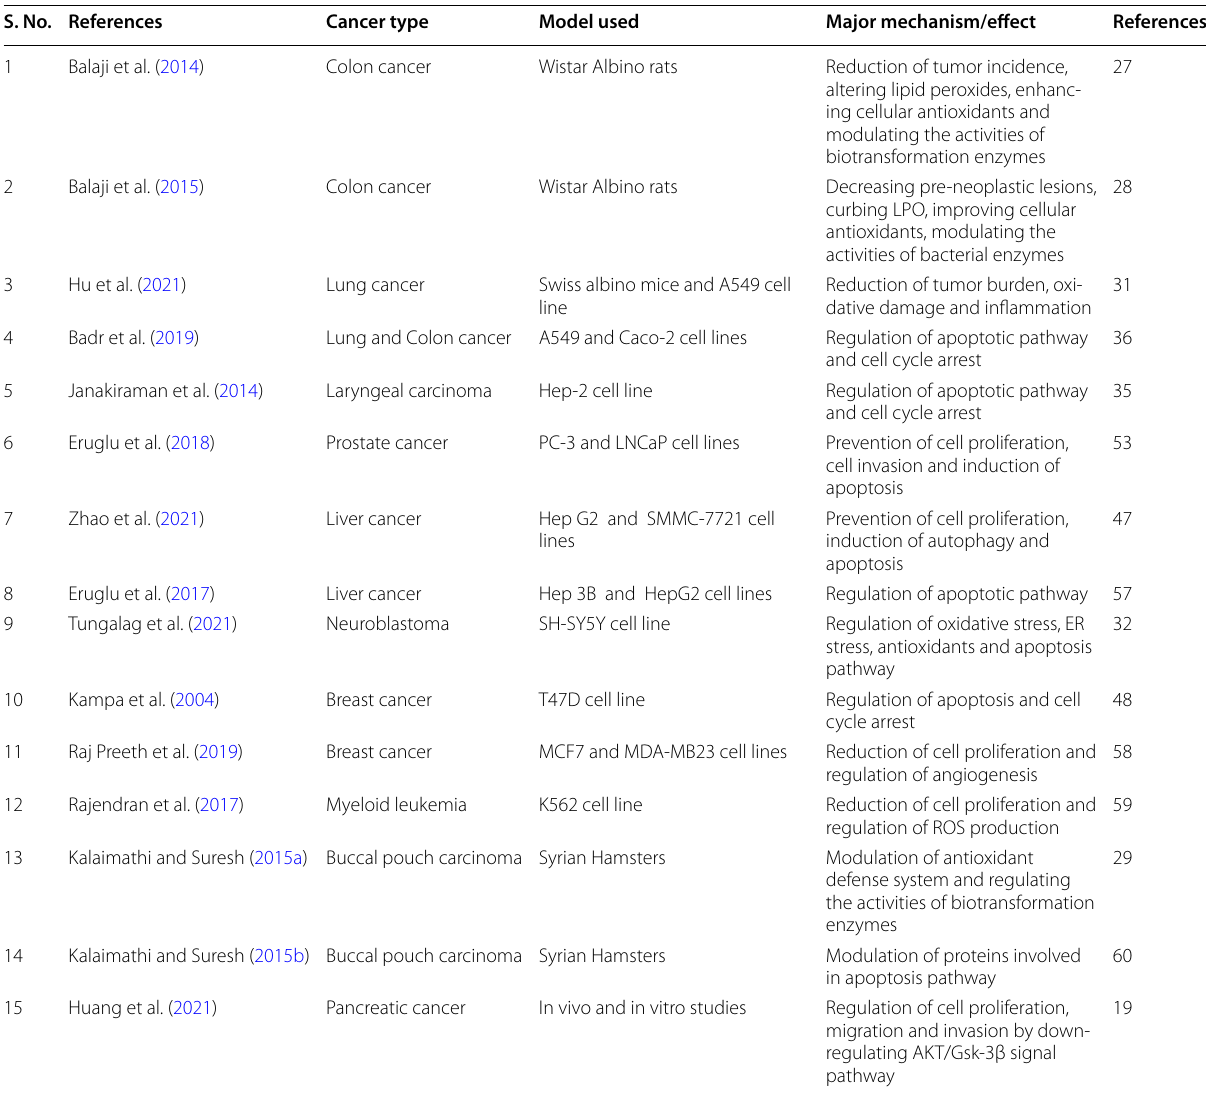
Table 1 Summary of the anticancer effects of Sinapic